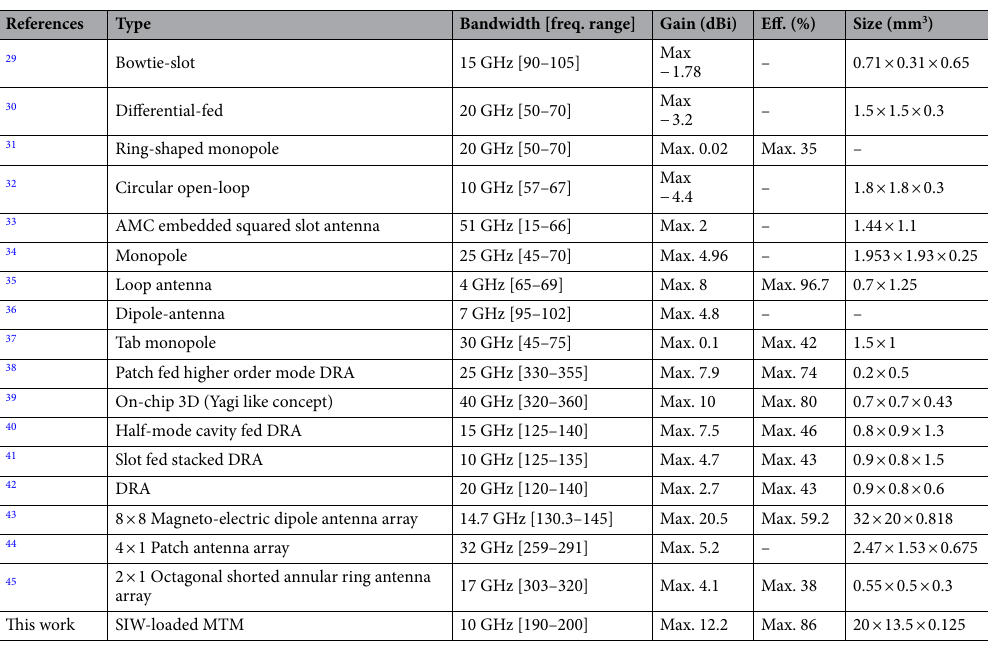
Table 3. Salient features of the proposed SIW-loaded MTM antenna array compared with recent